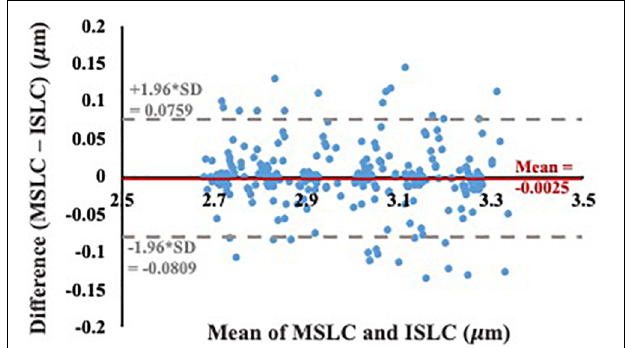
FIGURE 5 | Bland-Altman test of agreement between our individual sarcomere length code (ISLC) and the image processing method currently utilized in the literature, MSLC. The x-axis is the average of the MSLC and ISLC sarcomere length measurements and the y-axis is the difference between the sarcomere lengths calculated from the two methods. The solid red line indicates the bias (–0.0025 µ m) and the dashed gray lines represent the lower (–0.0809 µ m) and upper (0.0759 µ m) limits-of-agreement (mean difference ± 1.96*standard deviation of the